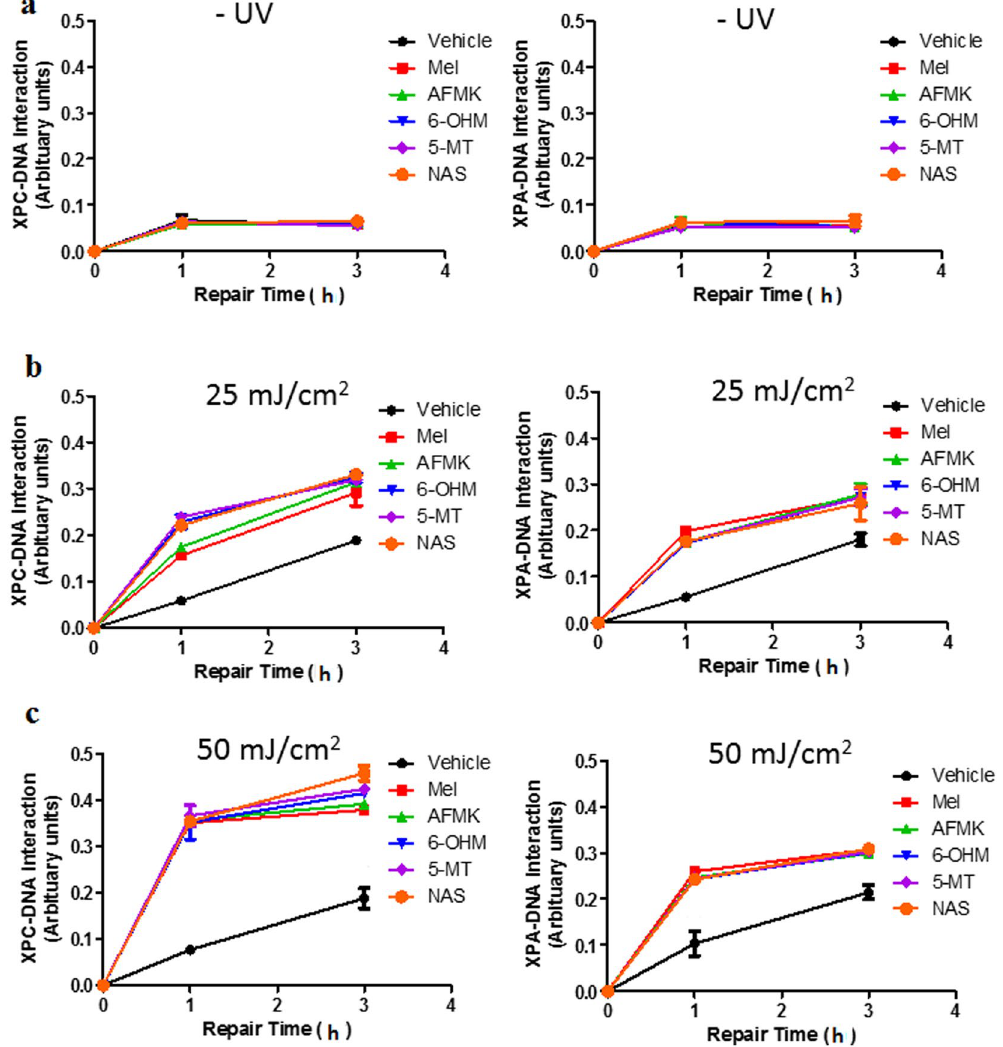
Figure 4. Melatonin and its metabolites enhance the XPC- and XPA-DNA-interaction. Melanocytes were treated with melatonin or its metabolites for 24 h in complete melanocyte medium. Cells were further exposed to either ( a ) non UVB-treated (0 mJ/cm 2 ) or ( b ) 25 mJ/cm 2 or ( c ) 50 mJ/cm 2 . Synthetic oligonucleotides (Molecular Beacons) were assembled to form 5 ′ -biotinylated duplex DNA fragment. The substrate provides a substrate for NER proteins and DNA-protein interactions were determined using anti-XPC and anti-XPA antibodies as described in the Methods. Treatments significantly different from vehicle were determined by one- way ANOVA; * p ≤ 0.05. All treatments in B or C were statistically significant when compared to